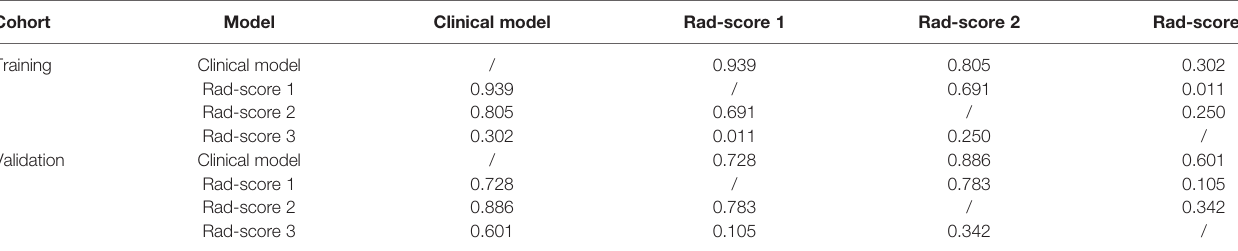
TABLE 2 | AUC comparison based on DeLong test among four models.